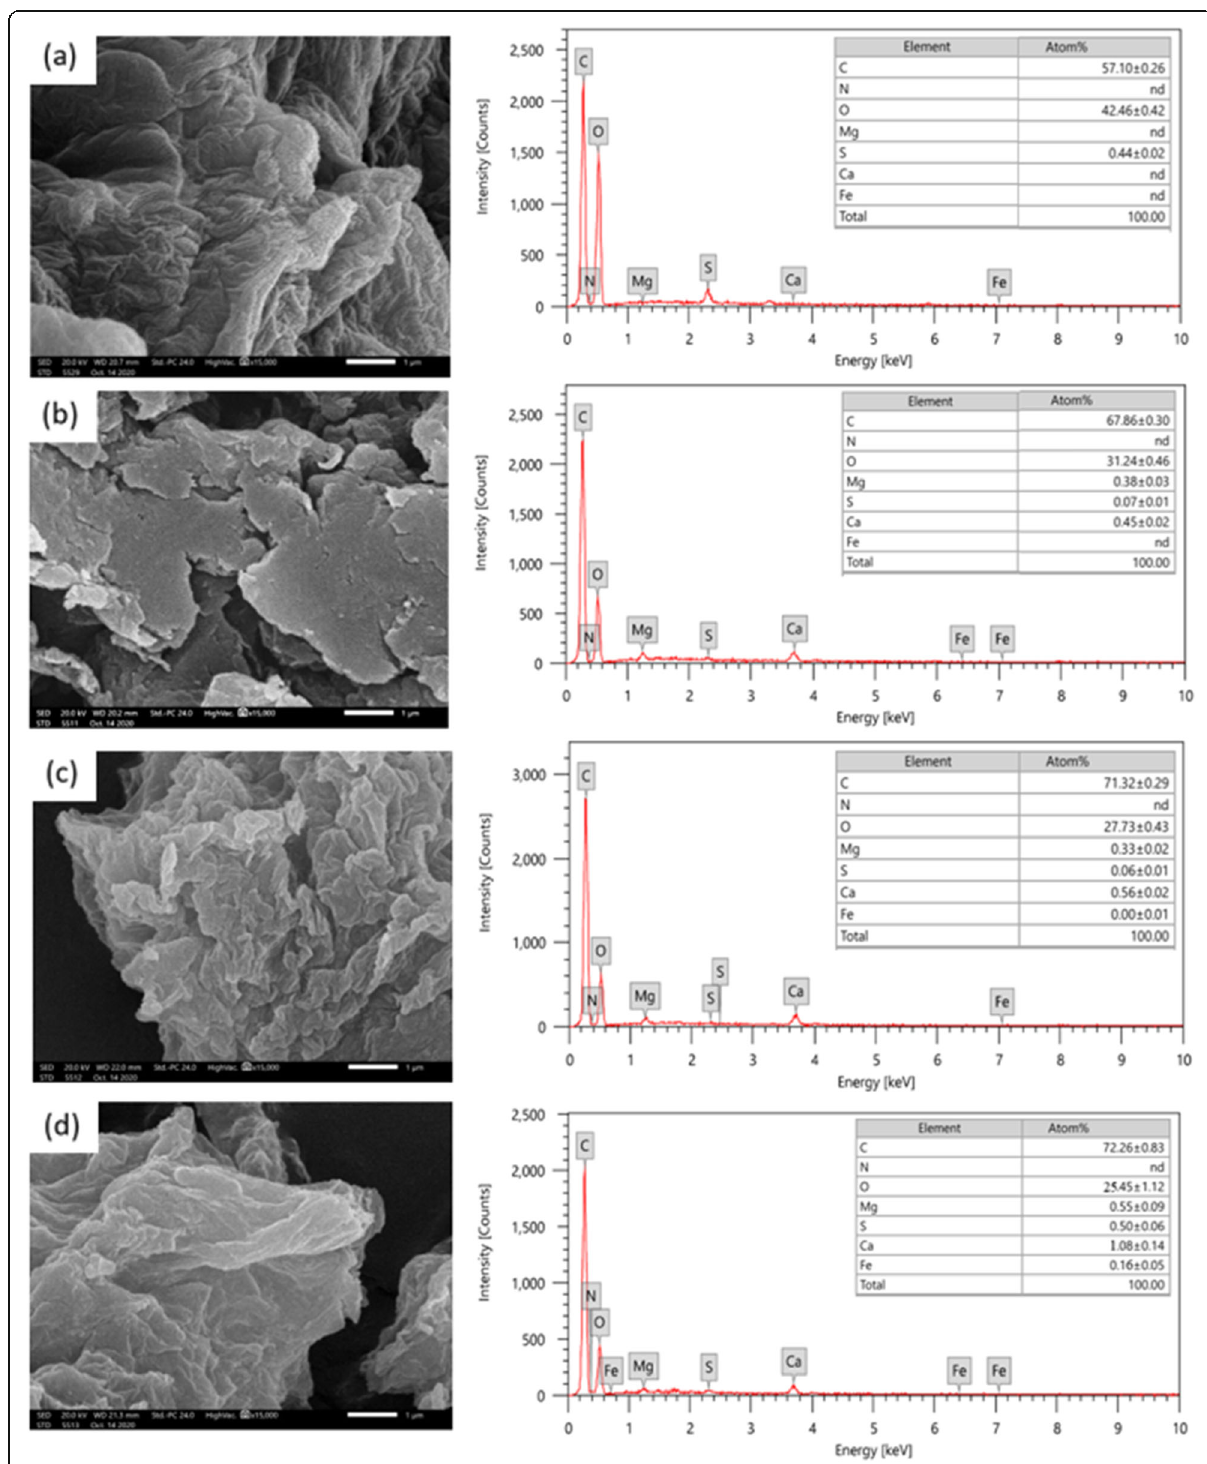
Fig. 1 SEM micrographs (left) and EDX (right) of ( a ) graphite oxide (GO), and reduced graphene oxide (rGO) with ( b ) 5 mg mL − 1 , ( c ) 25 mg mL − 1 , ( d ) 50 mg mL − 1 Tecoma stans leaves